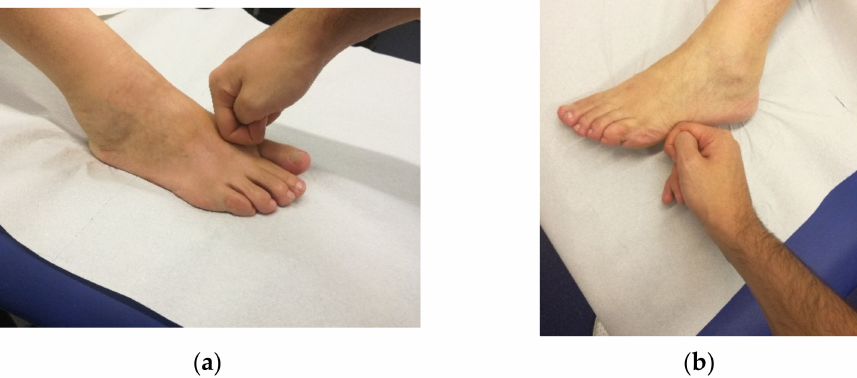
Figure 2. Example of manual friction using knuckles applied on ANTE-PES ( a ) and RETRO-PES ( b ) points during the FM session of a patient affected by